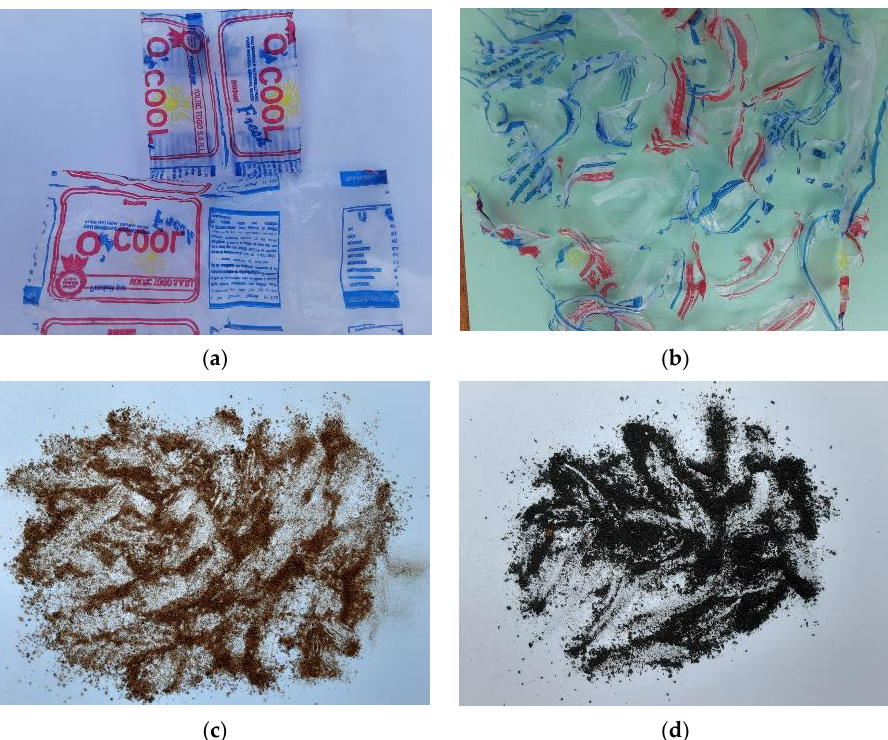
Figure 3. Details of the input material used in manufacturing the pavement. ( a ) Cleaned LDPE plastic water bag waste. ( b ) Shredded LDPE plastic water bag waste. ( c ) Sifted sand. ( d ) Sifted